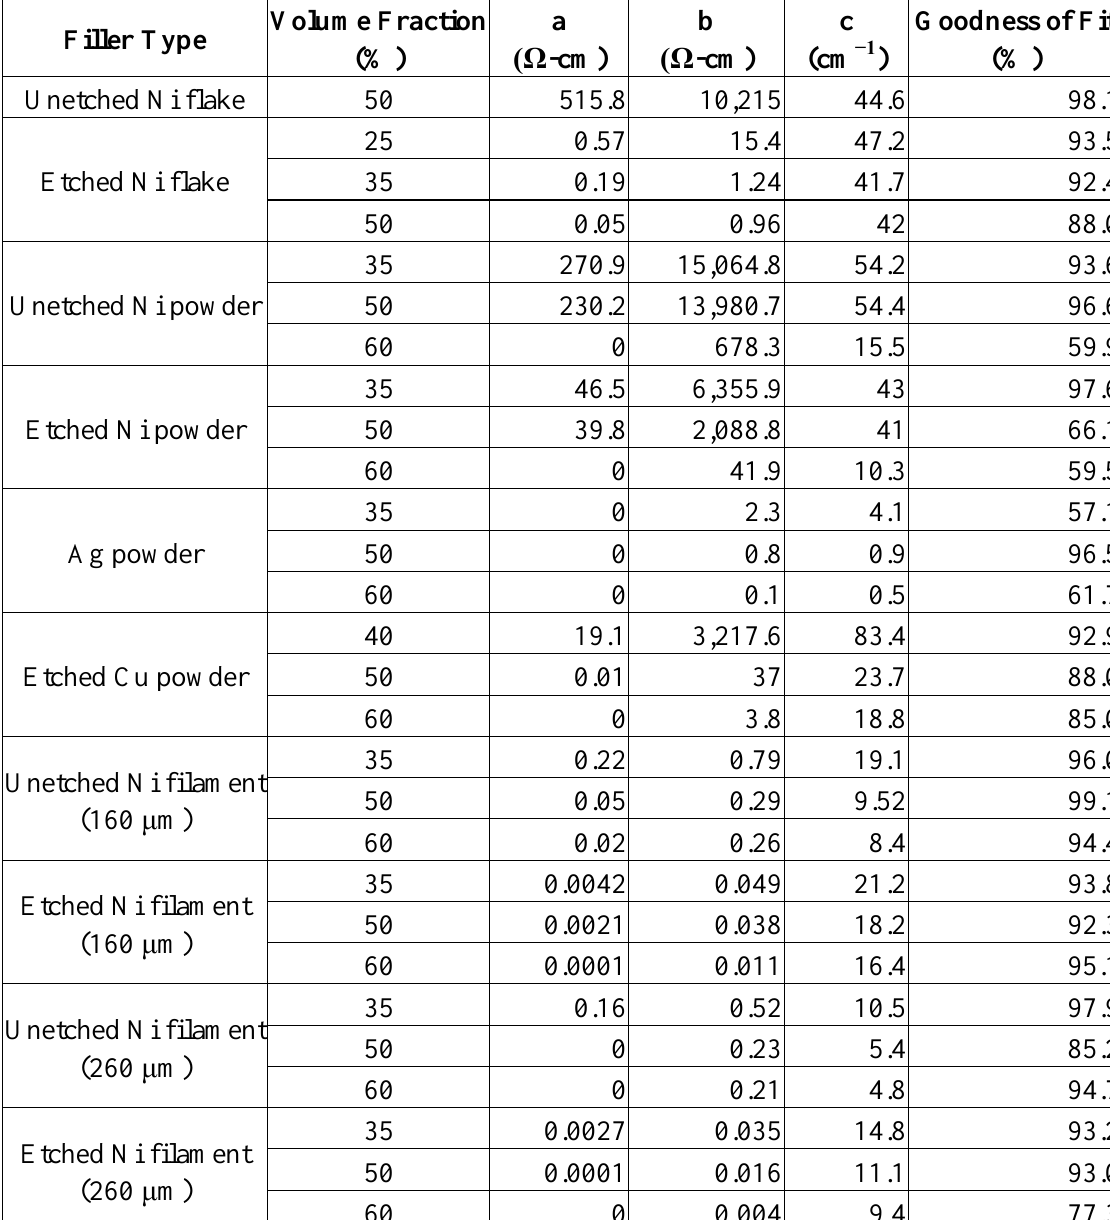
Table 2. The material parameters of the decaying exponential function  = a + b × Exp (−ct) describing the thickness-dependent conduction behavior with various conductive particles in Epon 830